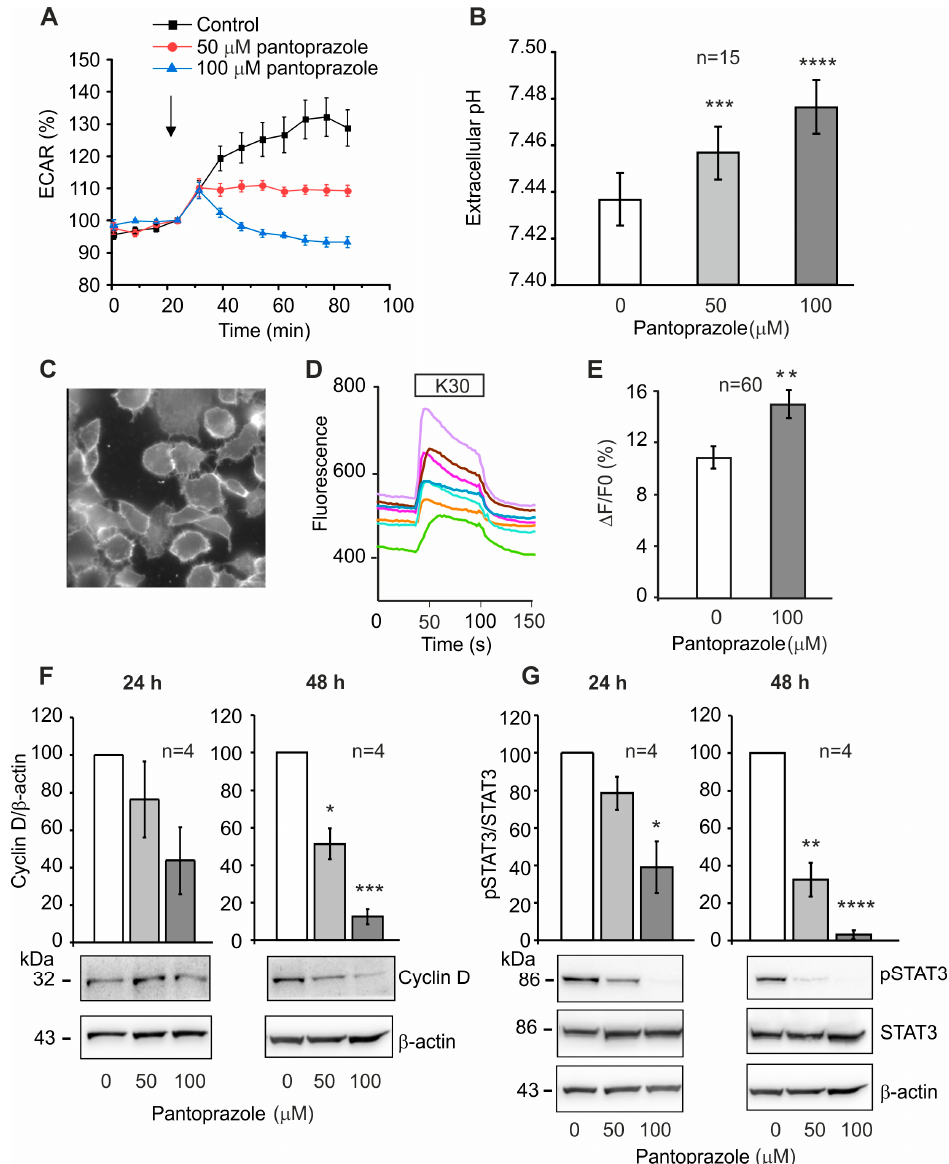
Figure 5. Pantoprazole has fast effects on extracellular pH and membrane potentials in PANC-1 cells. ( A ) Extracellular acidification rate monitored in Seahorse was normalized just prior to injection of control or pantoprazole solution. Extracellular acidification rate (ECAR) stabilizes within 15–20 min following “disturbance” due to injections. Representative experiment showing mean of 6 replicates ± s.e.m. ( B ) Readouts of extracellular pH measurements monitored by SNARF fluorescence (at 15 min) in control and pantoprazole treated cells. Pantoprazole increased extracellular pH in chronically and acutely treated cells (merged data for 24 h, 1 h and 15 min treatments). Data are shown as means ± s.e.m. from 15 experiments (50 µM: ***P = 0.0006, and 100 µM: ****P < 0.0001, paired t-tests). ( C ) Representative image of PANC-1 cells loaded with membrane voltage sensitive fluorophore VF2.1.Cl. ( D ) Typical response of several cells within one experiment in response to a 30 mM K + step. ( E ) Depolarizing effect of K30 in control cells and those pretreated with pantoprazole for 15–20 min. Response in 60 cells in 10 independent experiments (**P= 0.0034 (unpaired t-test)) . ( F–G ) Western blot quantification of cyclin D1 expression (normalized to β -Actin) and p-STAT3 (normalized to total STAT3 level) with representative blots. (F) Effect of pantoprazole on cyclin D1 expression after 24 and 48 h (48 h: 50 µM (*P = 0.0100) and 100 µM (***P = 0.0002), one-sample t-test) and (G) STAT phosphorylation after 24 h (100 µM: *P = 0.0220) and 48 h treatment (50 µM: **P = 0.0049 and 100 µM: ****P < 0.0001, one-sample